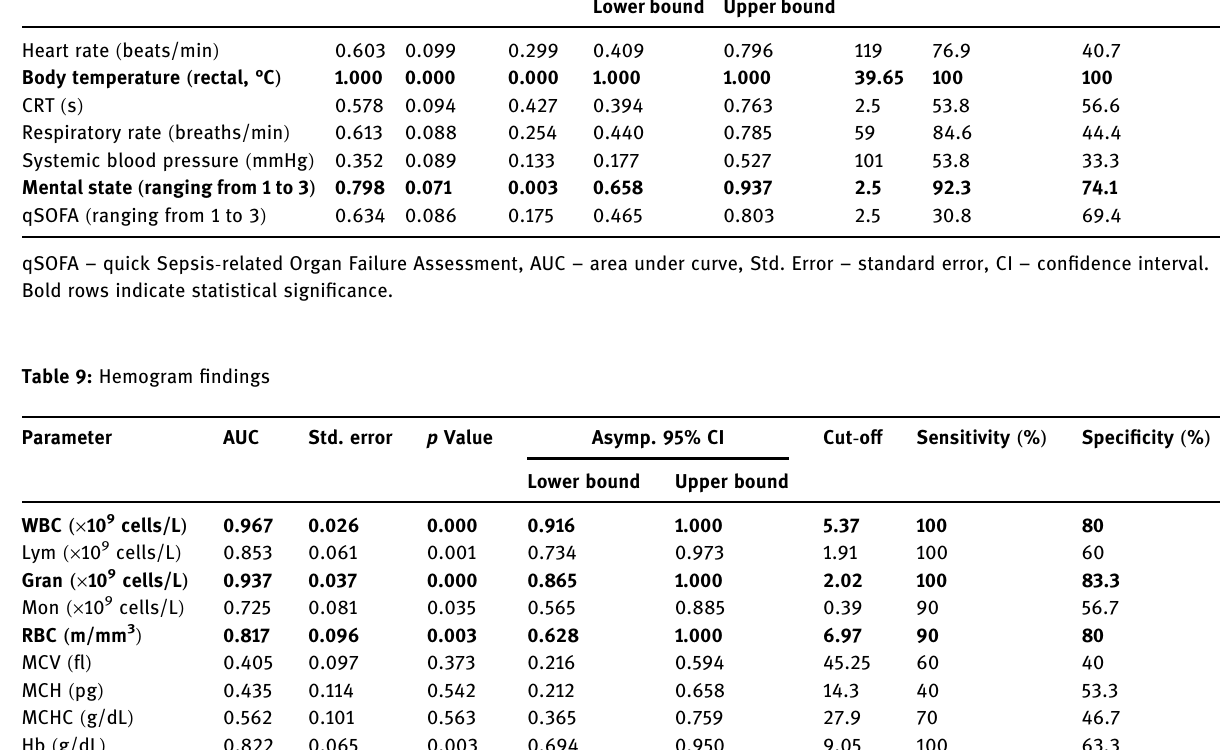
Table 8: Clinical examination fi ndings and qSOFA score Parameter